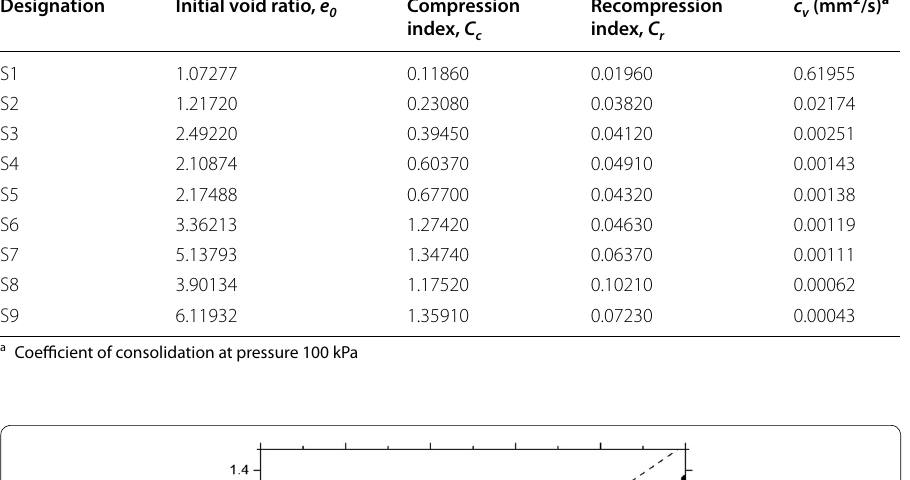
Table 3 Summary of compressibility parameters of the homogeneous soil mixtures